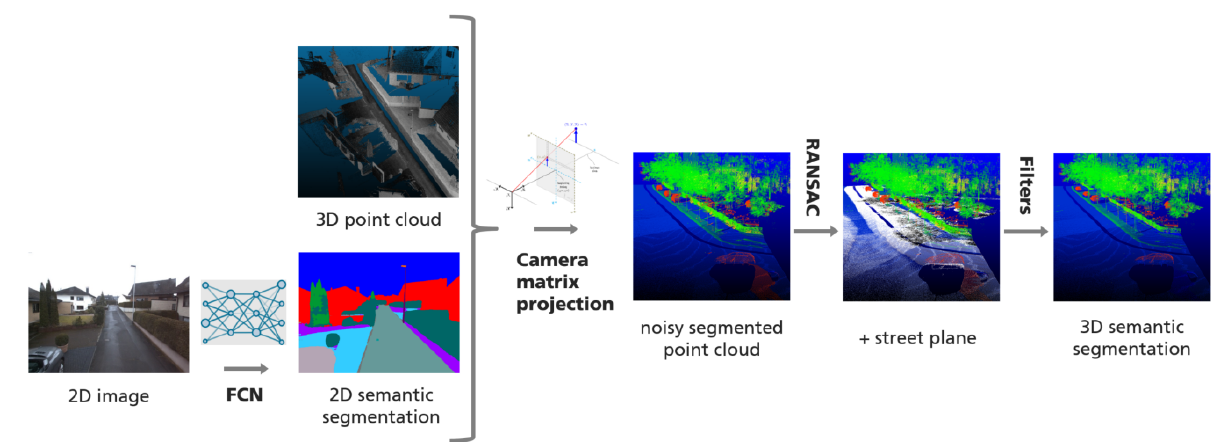
Figure 1. Pipeline and components of the deep learning